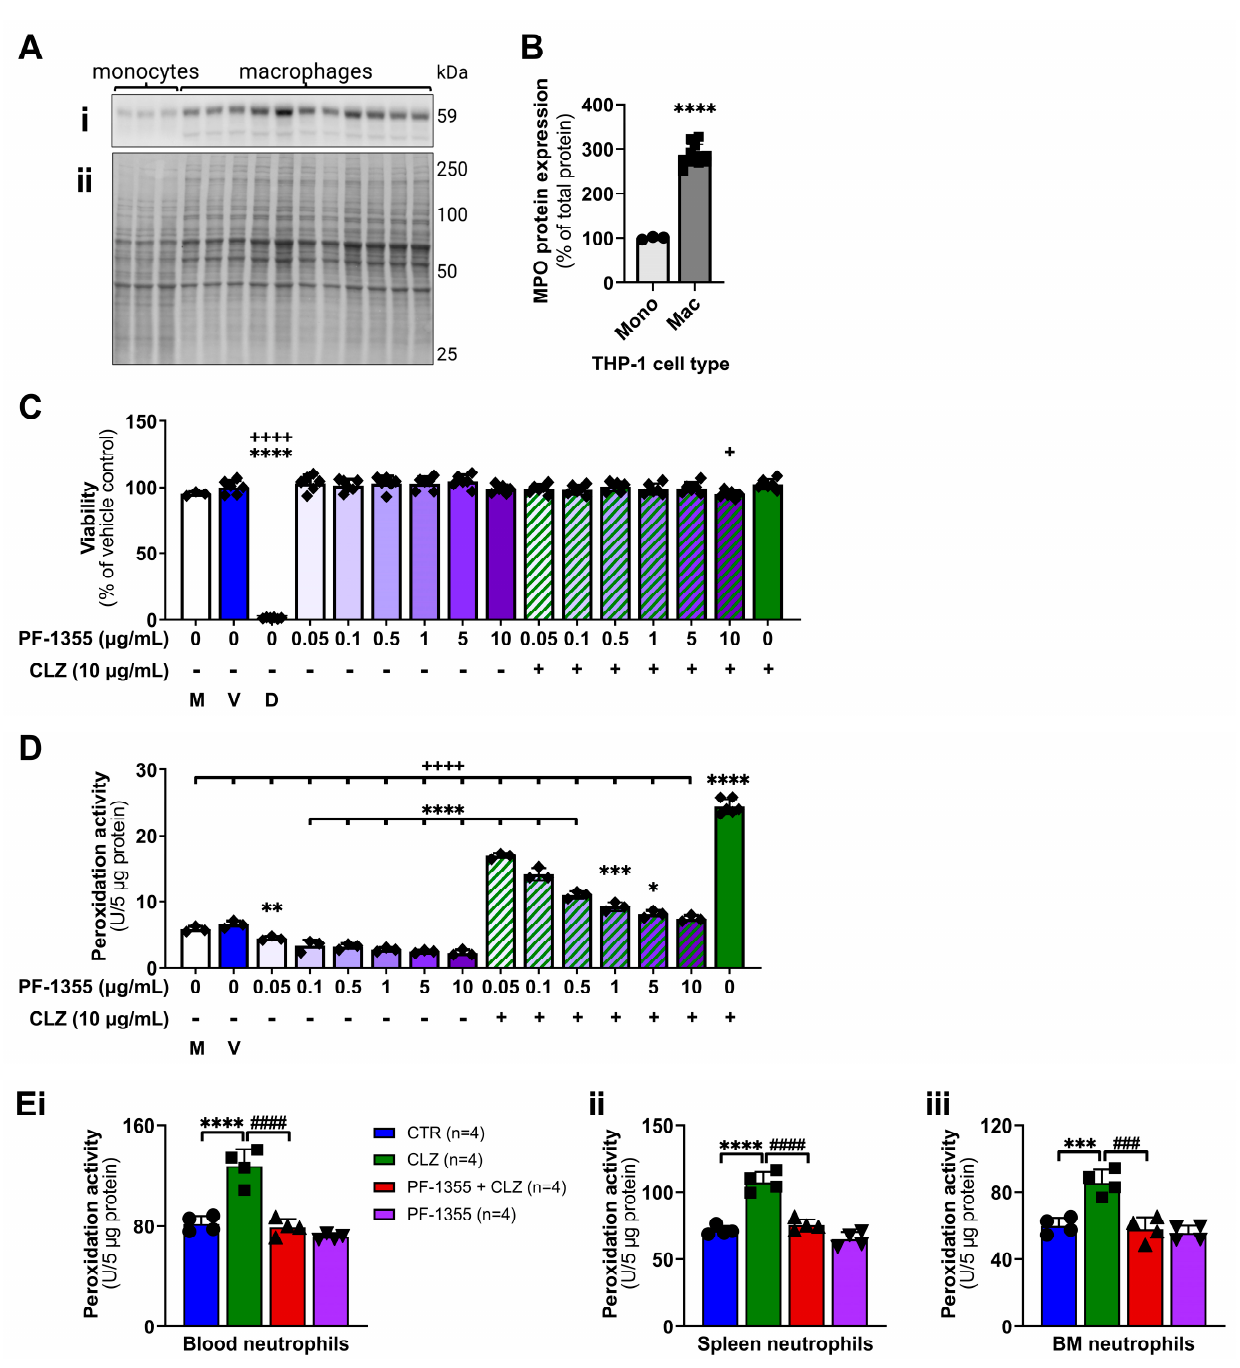
Figure 3. Clozapine increases myeloperoxidase activity in THP-1 macrophages and rat neutrophils. ( A , B ) Immunoblot analysis to detect myeloperoxidase protein expression in THP-1 cells. Protein (10 µ g) from THP-1 monocytes or PMA-differentiated macrophages was run on 10% precast gels, transferred to the nitrocellulose membrane, and stained for total protein (Ai) and myeloperoxidase (Aii), prior to densitometry analysis ( B ). Myeloperoxidase band density was normalized to total protein and data are presented as a percentage of monocyte myeloperoxidase expression. ( C ) Cell viability of THP-1 macrophages after 24 h of incubation with media, vehicle control, 10% DMSO, clozapine (10 µ g/mL), PF-1355 (0.05–10 µ g/mL), or clozapine with PF-1355. Viability was determined using a CCK-8 assay and data are presented as a percent of vehicle controls. ( D , E ) Myeloperoxidase peroxidation activity in THP-1 macrophages after 3 h of incubation with media, vehicle control, 10% DMSO, clozapine (10 µ g/mL), PF-1355 (0.05–10 µ g/mL), or coincubation with clozapine and PF-1355